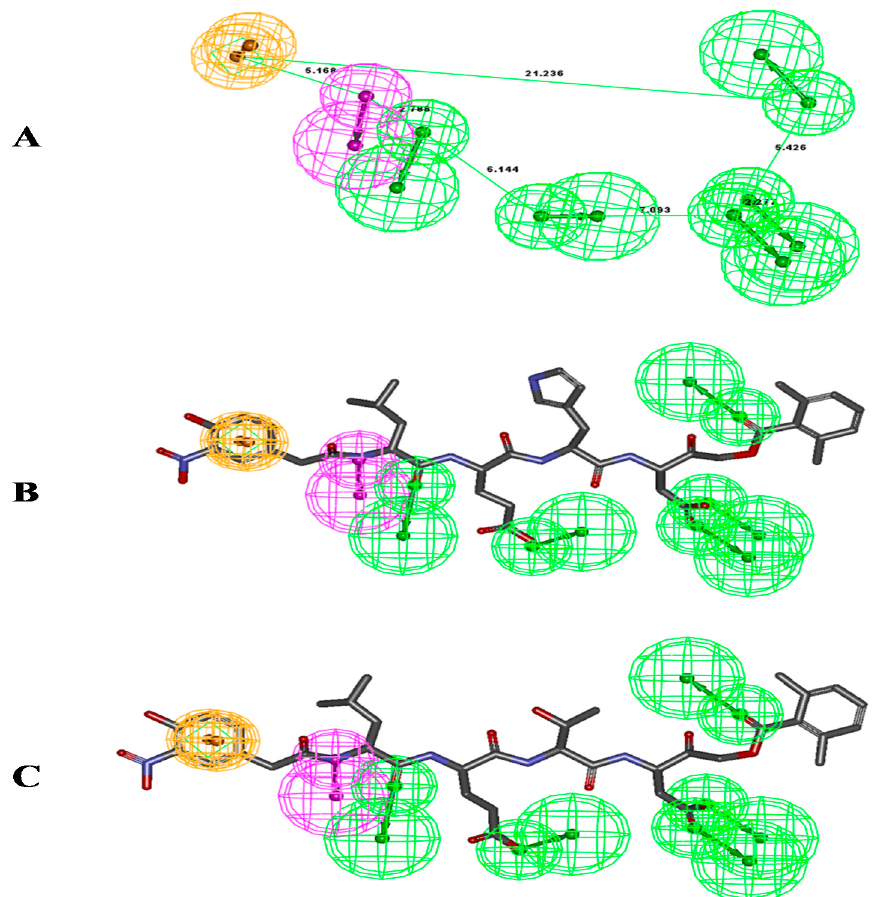
Figure 2. Pharmacophore mapping of compounds ( A ) Pharmacophore model developed using the training set compounds. ( B ) Mapping of the most active compound NP-LHED-AOMK from the training set compounds. ( C ) Pharmacophore mapping of the least active compound NP-LTED-AMPK on pharmacophore. The color represents R, ring aromatic (Orange); D, hydrogen bond donor (Purple); A, hydrogen bond acceptor; H (Green), hydrophobic group and P, positive ionisable (Red). In the direct hit mask, (1) every feature of the training set molecules were mapped; (0) indicates